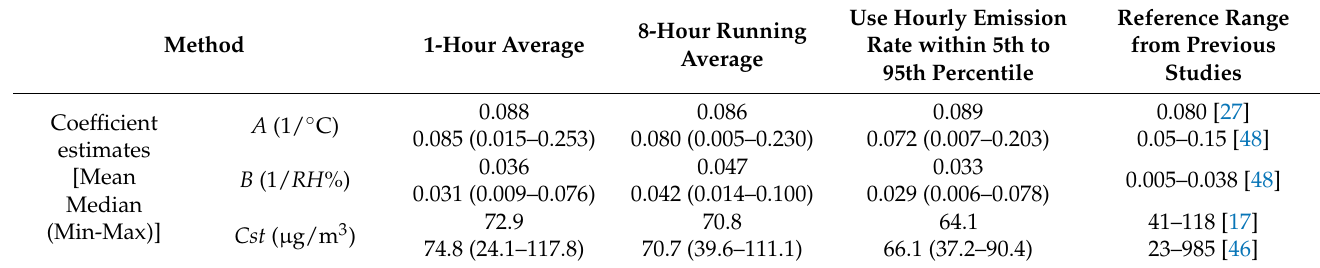
Table 2. Summary of regression coefficients in selected